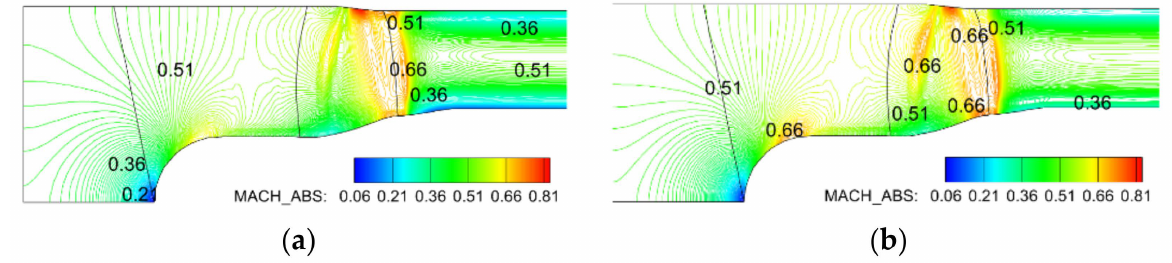
Figure 25. Isoline of the Mach number for 11D: ( a ) distorted; ( b ) clean.